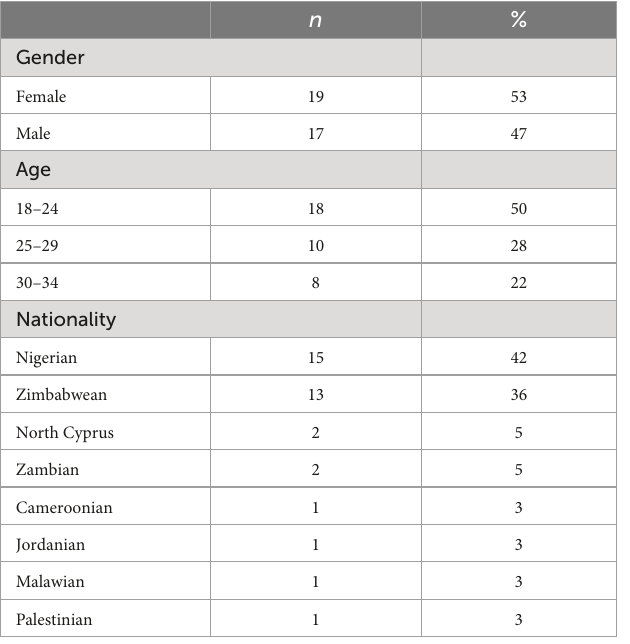
TABLE 1 Demographic characteristics of the research